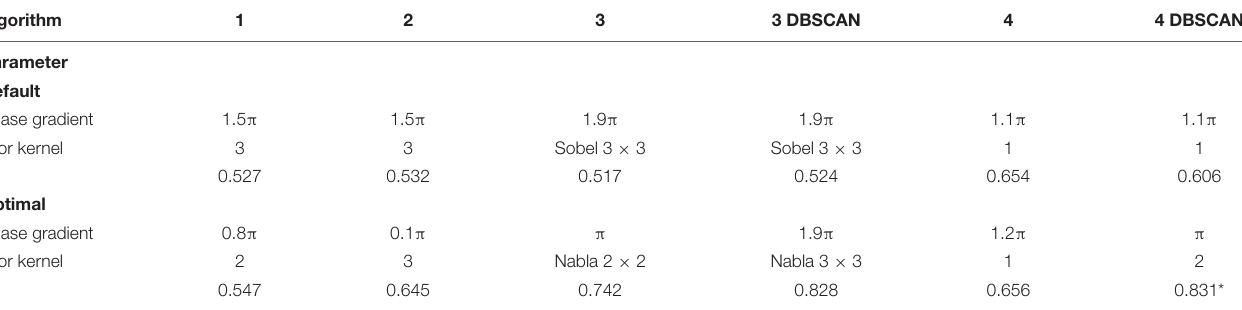
FIGURE 3 | The effect of different phase gradient thresholds. (A) An example of the performance of the Algorithms 1–4 and Algorithm 3 and 4 with DBSCAN different phase gradient thresholds, the bottom row is the 3D and 2D phase map with manual annotation. (B) PSD maps of the example VEGMs (476.5 ms) using algorithms with different phase gradient thresholds, the bottom row is the 3D and 2D PSD maps with manual annotation. TABLE 1 | The F β scores (accuracy measurement vs. “gold standard”) of each algorithm with their default parameter settings and revised optimal